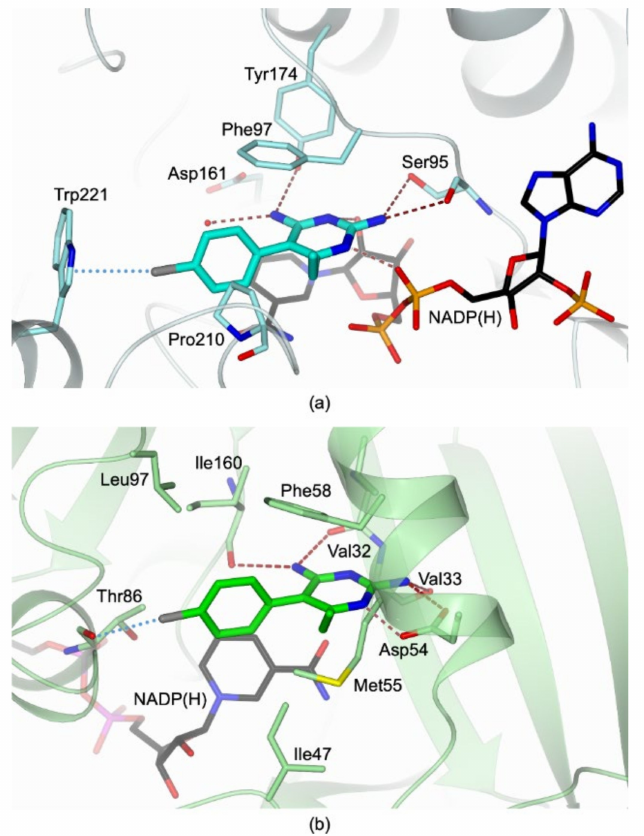
Figure 6. Active-site view of ( a ) TbPTR1 (light cyan cartoon and carbon atoms; residues in sticks) in complex with NADP(H) (in sticks, black carbon atoms) and PYR (in sticks, cyan carbon atoms), ( b ) TbDHFR (light green cartoon and carbon atoms; residues in sticks) in complex with NADP(H) (in sticks, black carbon atoms) and PYR (in sticks, green carbon atoms; (PDB code 3QFX